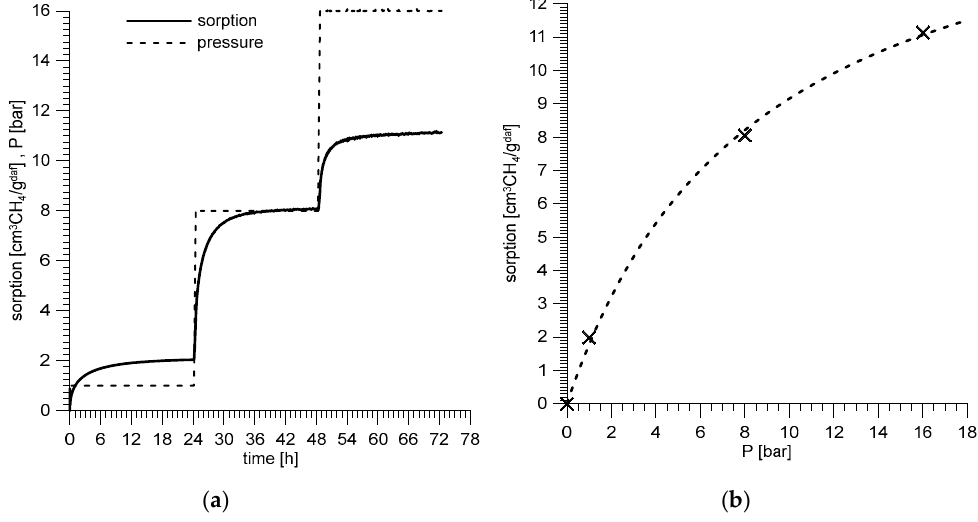
Figure 5. ( a ) Direct results of the sorption measurements—coal from the Budryk coal mine. ( b ) A sorption isotherm of the coal from the Budryk coal mine. Table 1. The results of the sorption measurements for coals from the post-outburst masses and average values for Zofi ó wka and Budryk coal